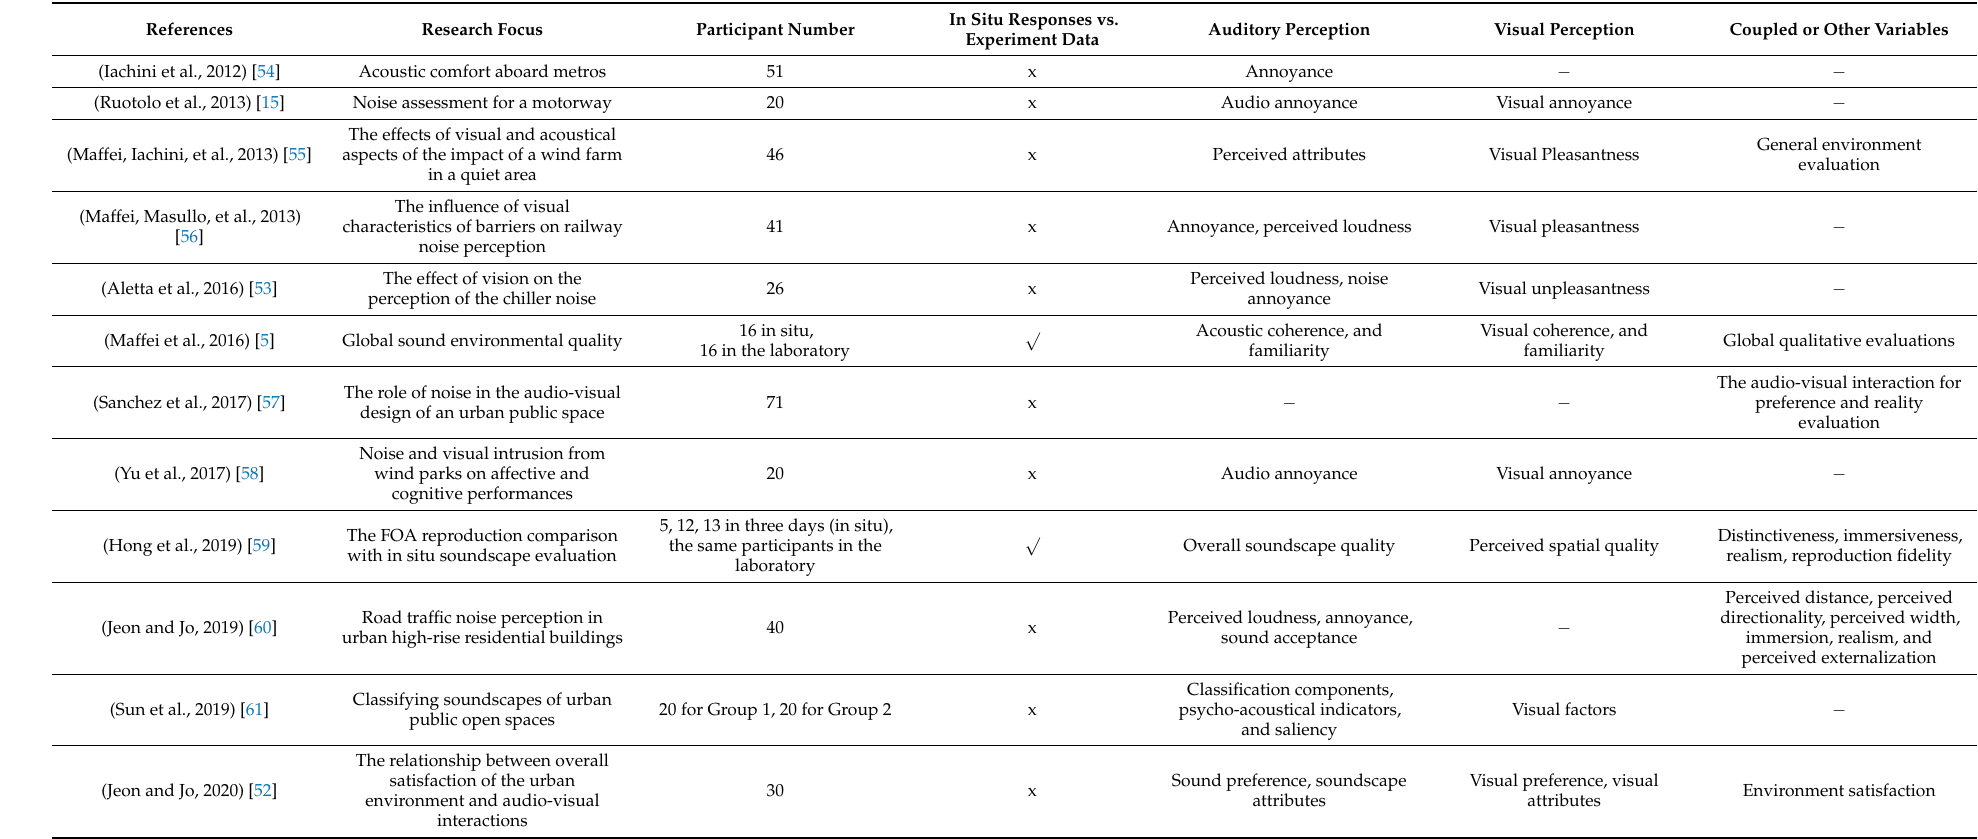
Table 1. Virtual environment evaluation studies with subjective